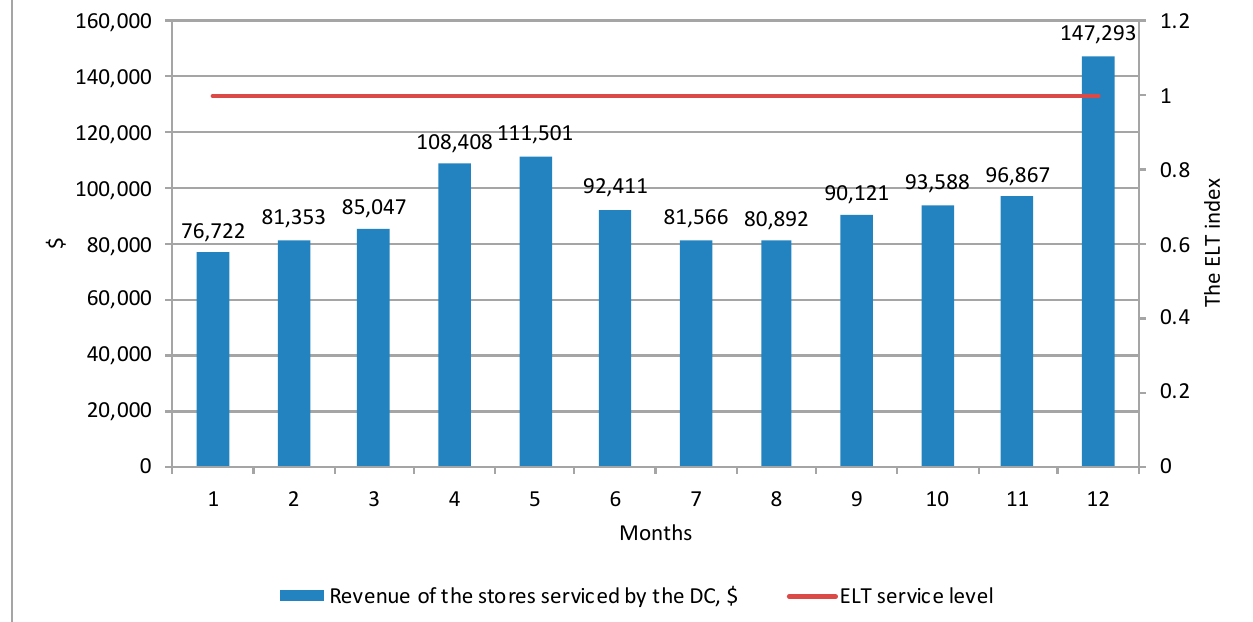
Figure 2. Key indicators of supply chain efficiency in the implementation of the second version of the model. The average order formation time for stores decreased to 1.2 days, which led to